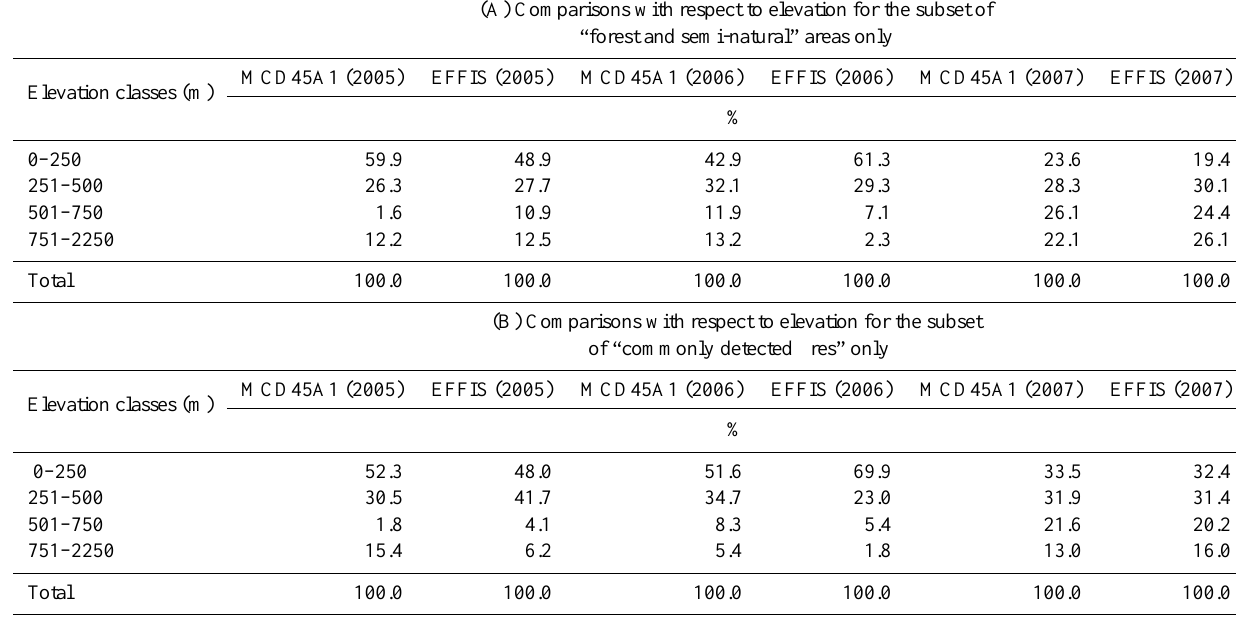
Table 3. Burnt area mapped by MCD45A1 & EFFIS operational products for the years 2007, 2006 and 2005 for the different elevation ranges derived from the ASTER GDEM operational product. (A) Comparisons with respect to elevation for the subset of “forest and semi-natural” areas